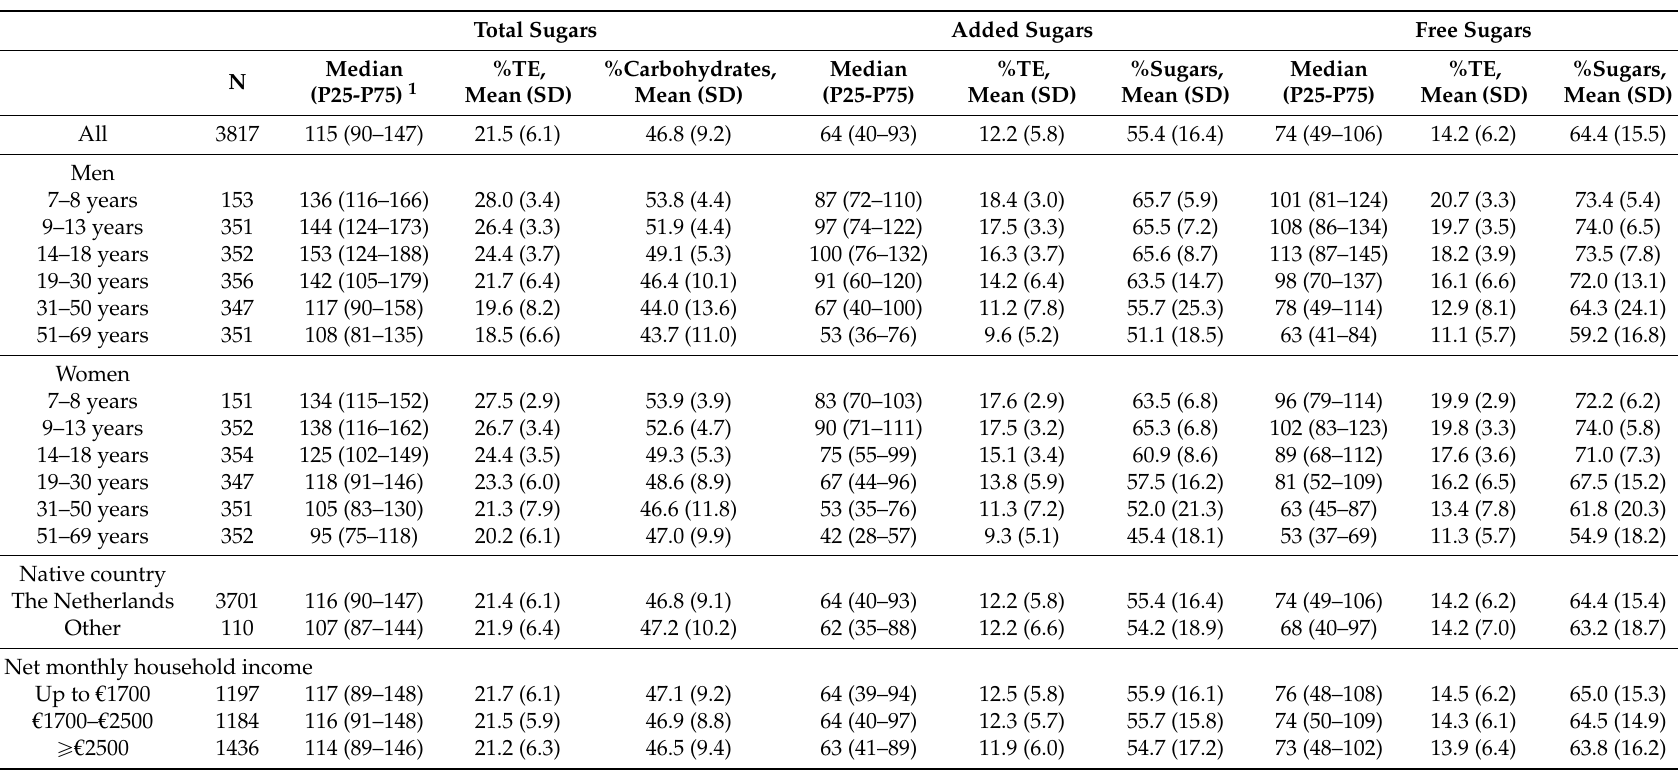
Table 1. Weighted * habitual intakes of total sugars, added sugars, and free sugars in 3817 persons aged 7–69 years from the Dutch National Food Consumption Survey